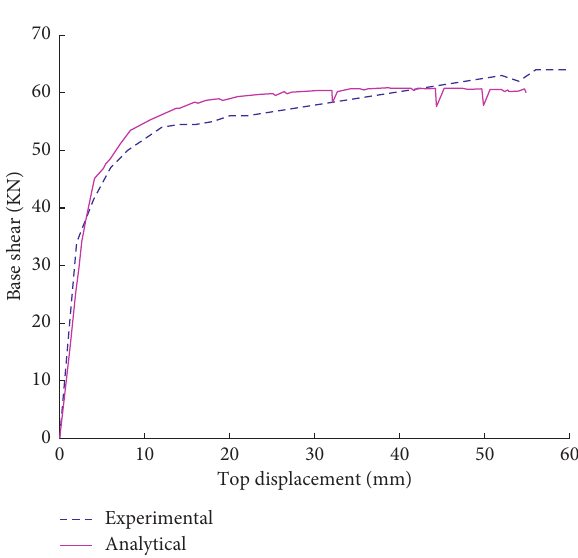
Figure 3: Pushover curve of the SNk-7.5-1 wall [18].